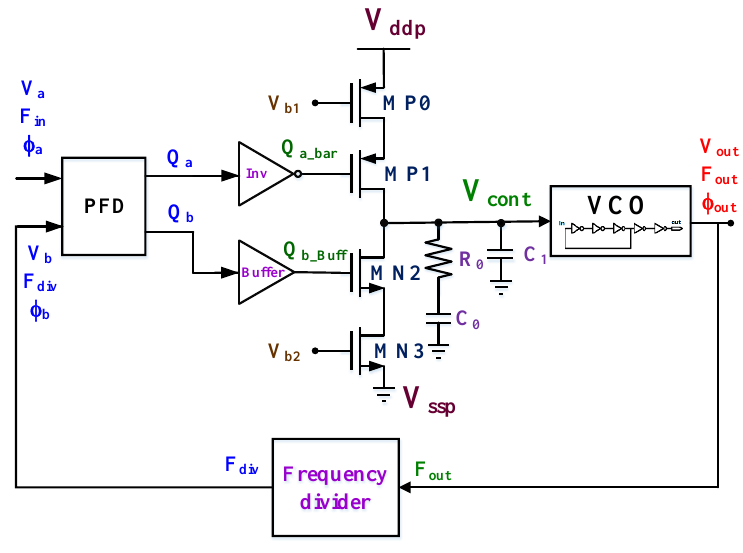
Figure 12. Adopted fundamental PLL.